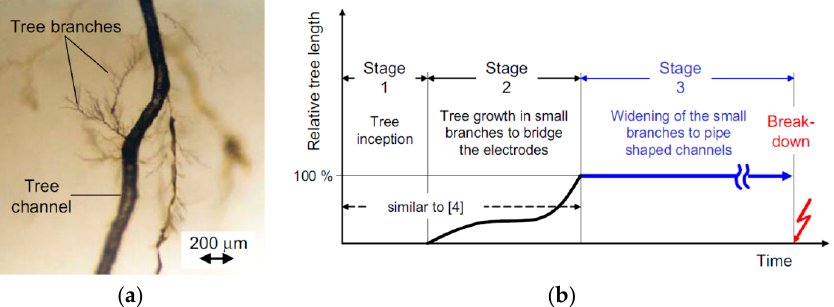
Figure 36. ( a ) Optical micrographs of tree branches and channel and ( b ) stages of electrical tree propagation until the final breakdown (© 2016 IEEE. Reprinted, with permission, from [164]).